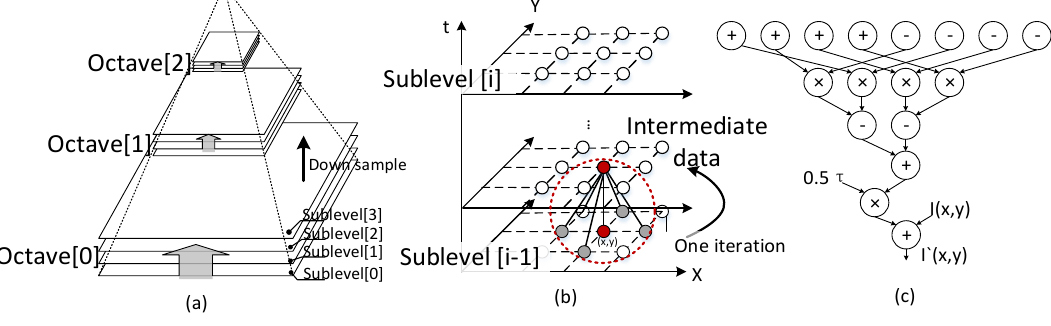
Figure 2. Nonlinear scale pyramid build process: ( a ) scale pyramid build process; ( b ) process to generate next sublevel (various iterations); ( c ) operations to update one pixel within an